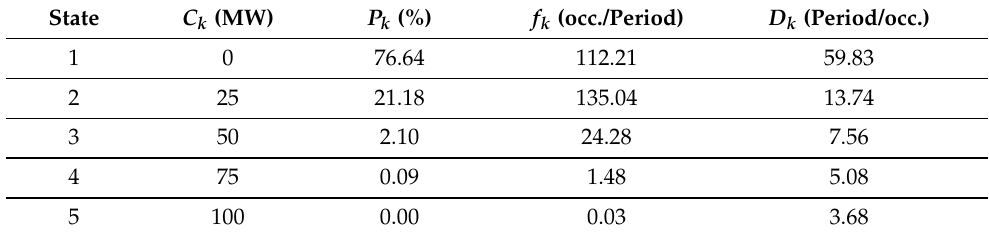
Table 7. Capacity outage probability table—scenario